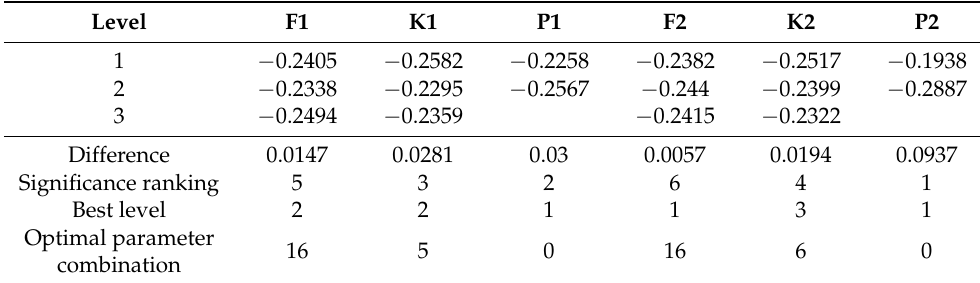
Table 7. Results obtained for each